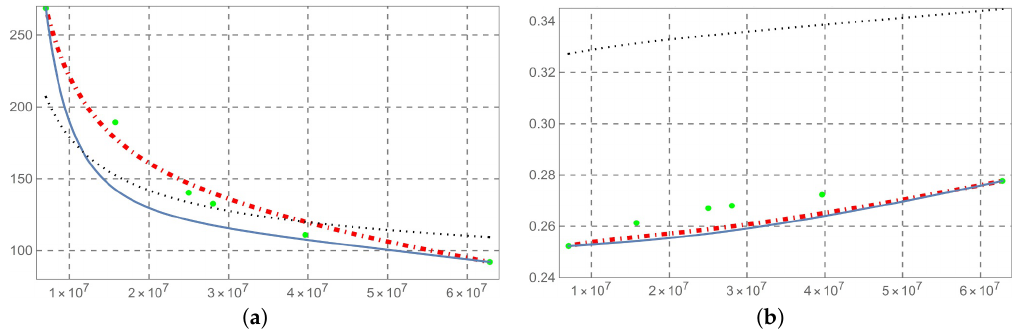
Figure 6. ( a ) Permittivity and ( b ) conductivity at frequencies 1 MHz @ 10 MHz. Line dot-dashed fractional model α = 0.975, line continue ordinary model, line dotted extensive Cole–Cole’s model, points experimental